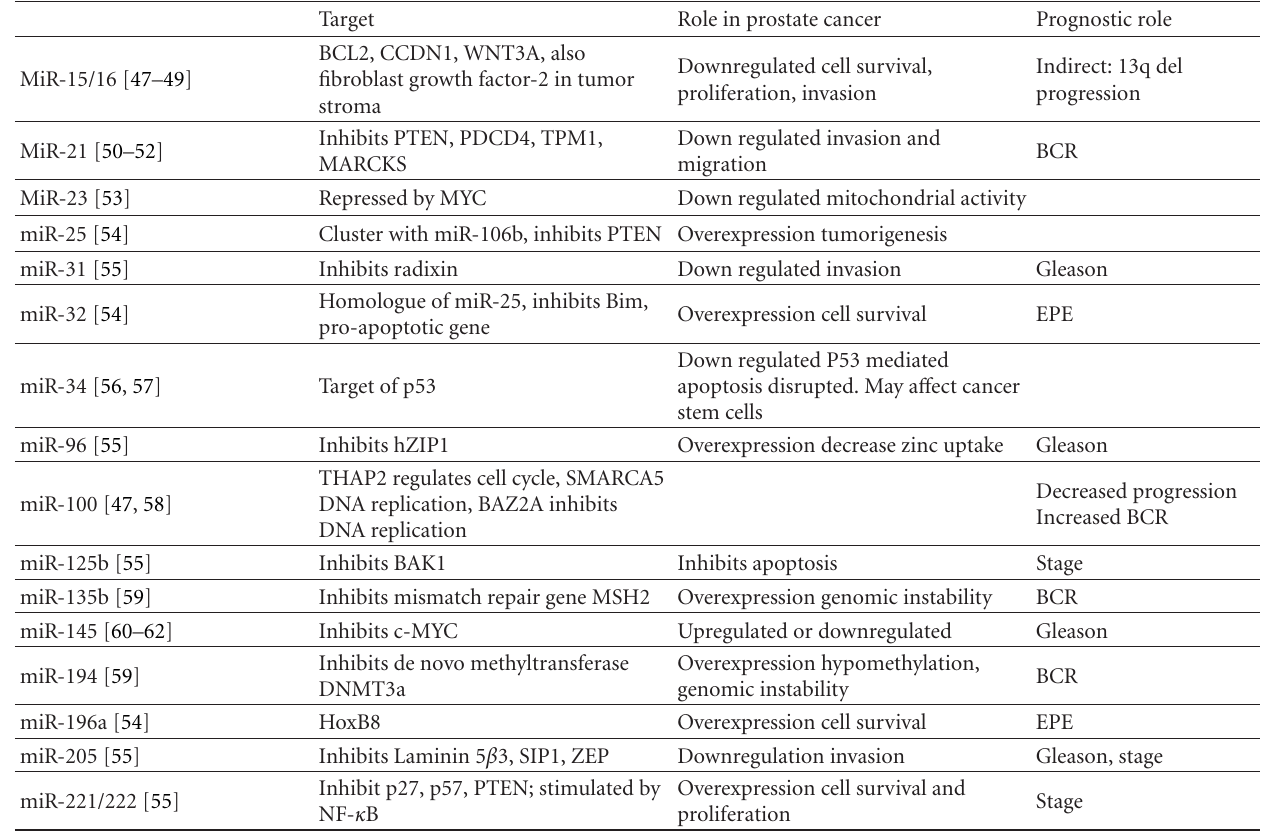
Table 2: Di ff erentially expressed microRNAs reported to be prognostic for prostate